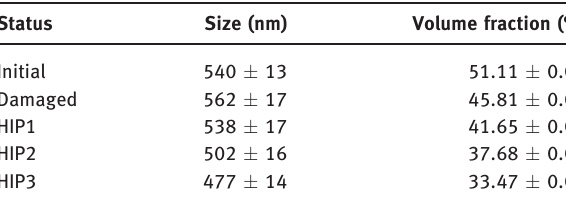
Table 2: Size and volume fraction of γ ′ for K002 superalloy in different